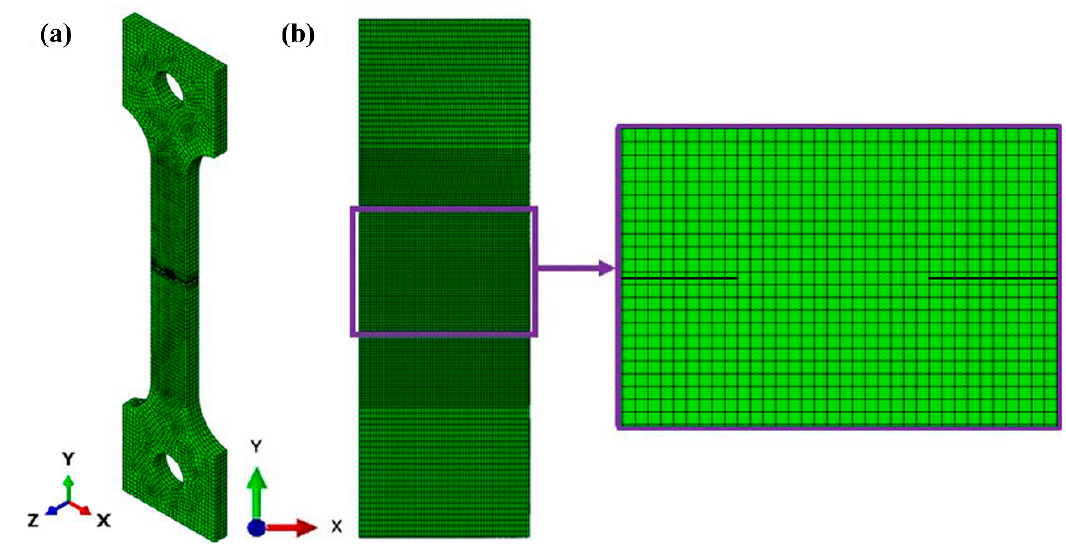
Figure 15. Finite element model of the sample containing two symmetric cracks on either side: the initial ( a ) and final geometry ( b ).